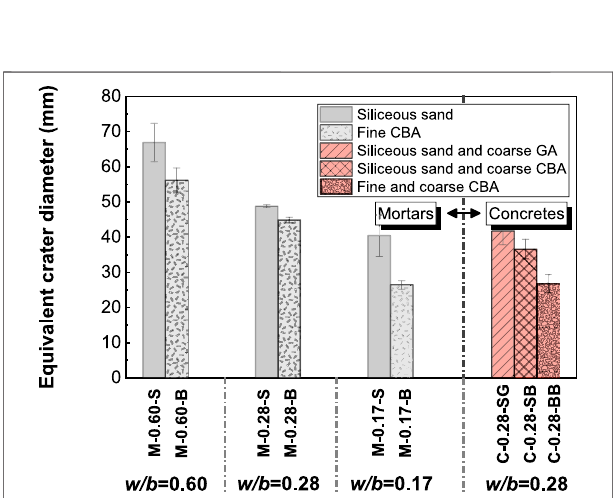
FIGURE 12 | Effect of CBA on the CD of cement composites subjected to deformable copper HVPI.